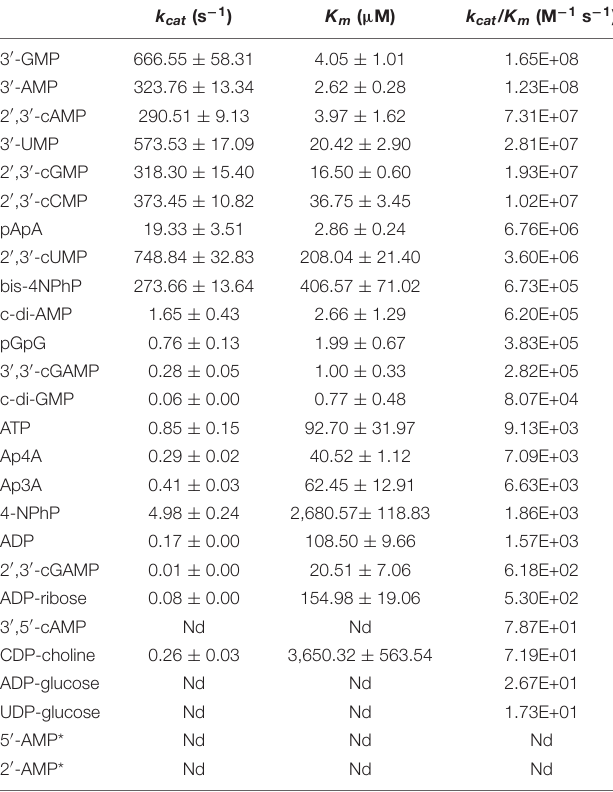
TABLE 1 | Kinetic parameters of